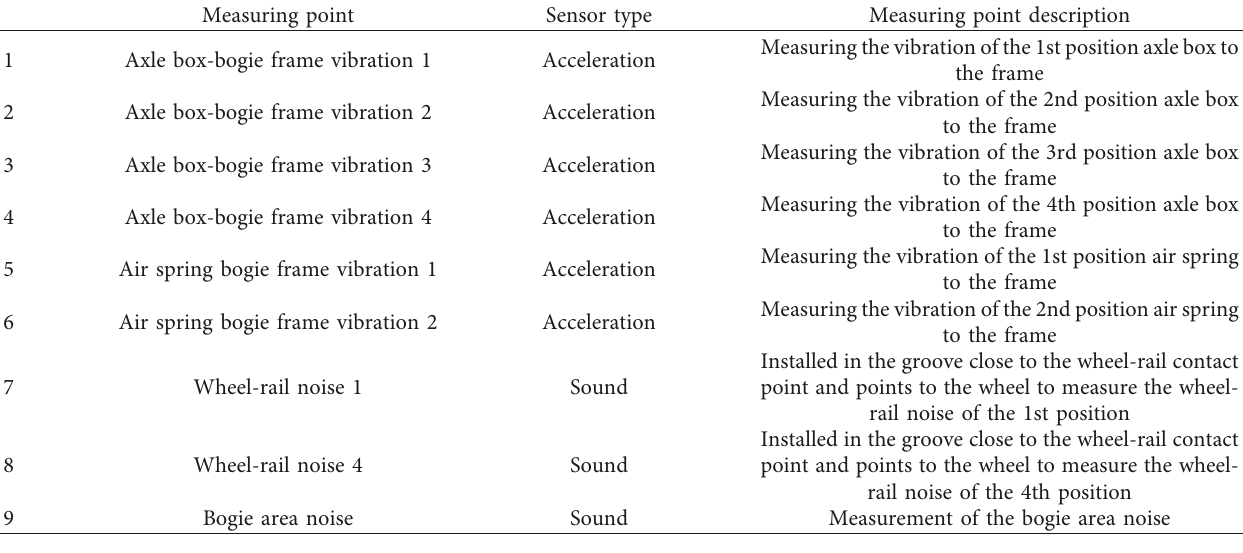
Table 1: Location and description of the measuring points.